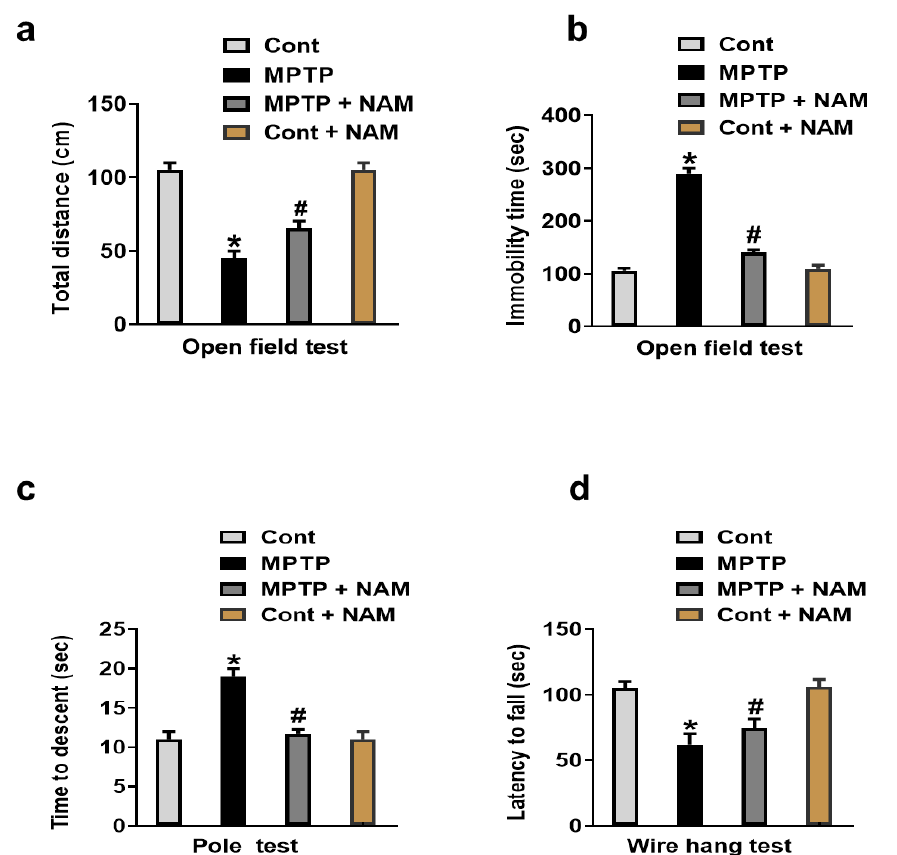
Figure 2. Nicotinamide (NAM) abolished motor dysfunction in MPTP-induced PD model. ( a , b ) Quantitative analysis of the total distance covered and immobility time by the mice in the open field box; ( c ) Representative histogram of the pole test results; ( d ) Histogram showing the results of the wire hang test. * Significantly different from the control group; # Significantly different from MPTP-treated mice. Significance. * p < 0.05; # p < 0.05. 3.2. NAM Decreased the Expression of α -Synuclein in the MPTP-Induced PD Striatum and SNpc α -synuclein is the main player of the Lewy bodies and the pathogenesis of PD. It has been confirmed that MPTP-induced mice produce α -synuclein in the brain [46]. We also evaluated the effects of NAM on MPTP induced α -synuclein aggregation in striatum and SNpc. Our Western blot results showed increased expression of α -synuclein in MPTP- induced PD mice brain, while NAM treatment significantly decreased the expression (Figure 3a,b). Through immunofluorescence, we further confirmed the beneficial effects of NAM on the MPTP-induced α -synuclein expression in the Striatum and SNpc (Figure